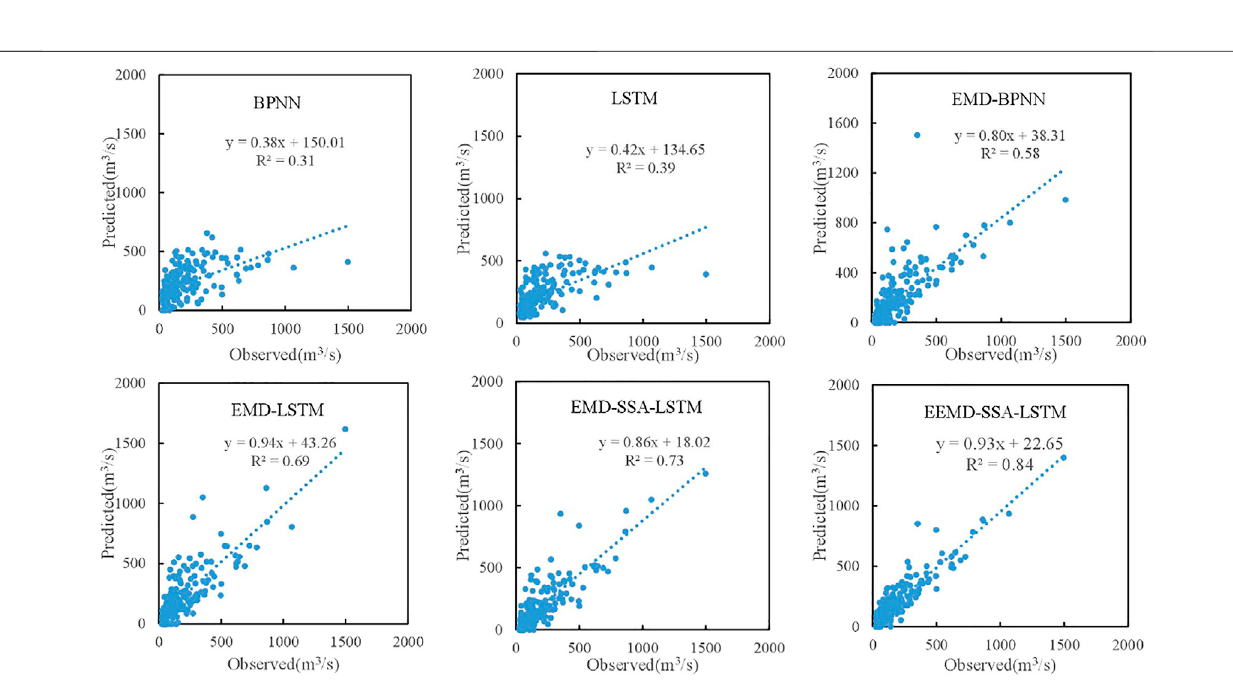
Frontiers in Environmental Science |